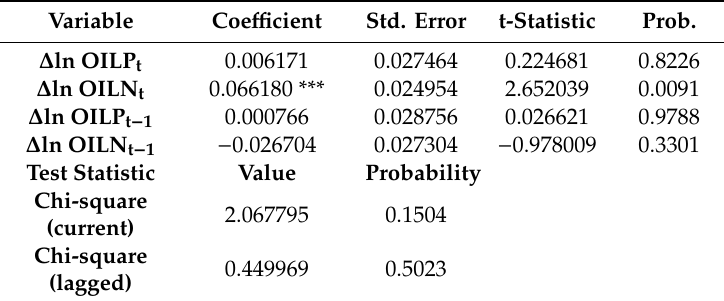
Table 25. Regression results for positive and negative oil price